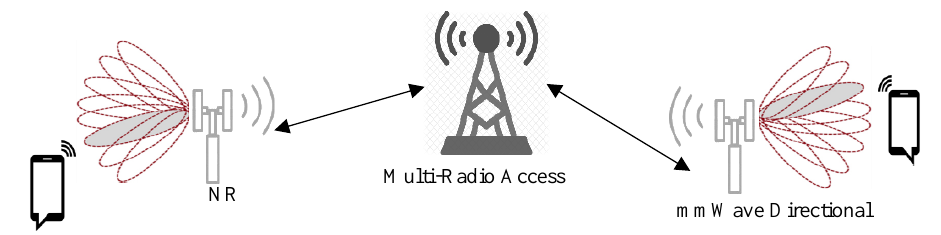
Figure 7. Options of the 5G architecture, multiple radio access technologies (RATs) [28]. 213